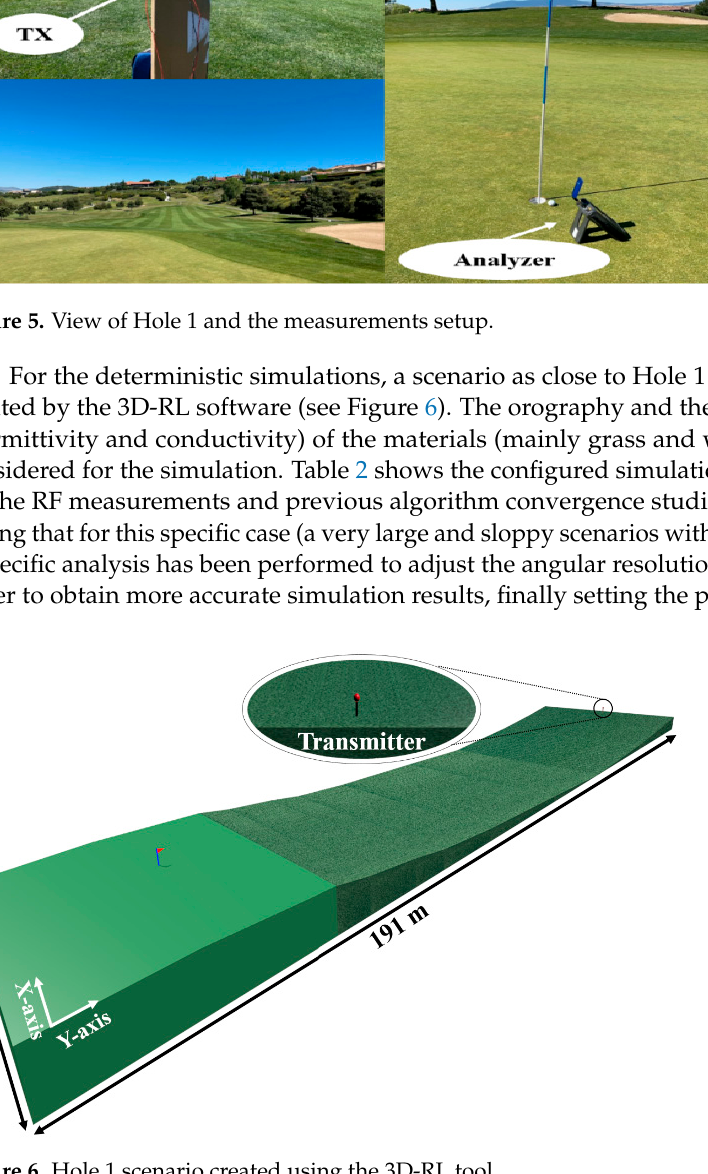
Figure 6. Hole 1 scenario created using the 3D-RL tool.